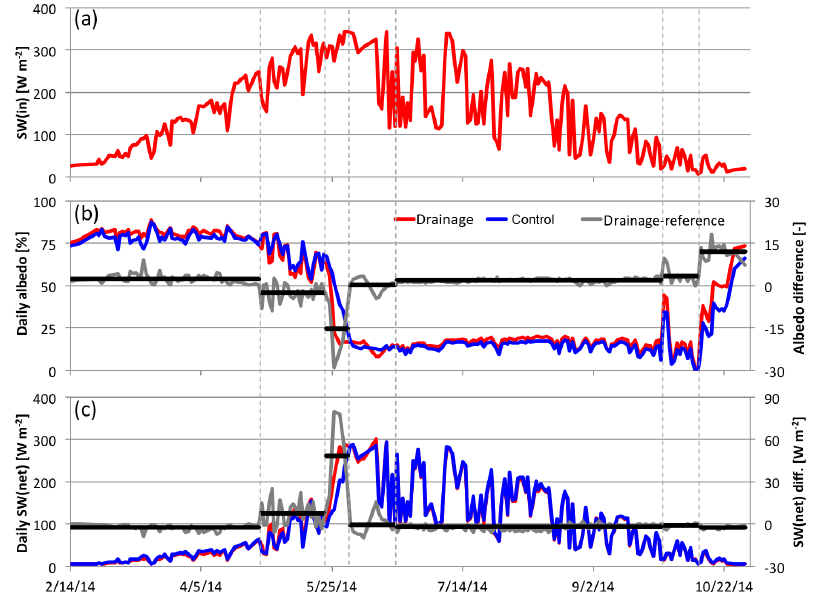
Figure 6. (a) 2014 annual course of the daily mean incoming shortwave radiation; (b) daily mean albedo derived from the ratio of downward and upward shortwave radiation. The grey line indicates the daily difference between drained and control towers (scales on the right), with the black horizontal bars giving the mean values for seven sub-seasons (separated by vertical dashed lines; see Table 2 for definitions); (c) same structure as used in the center panel, here to show the net shortwave radiation budget from both towers and their seasonal differences. All plots have been restricted to the period where SW(in) > 5Wm − 2 . Table 2. Definition of sub-seasons that reflect the pattern in albedo differences between drainage and control areas. Differences for albedo and net shortwave radiation budget SW(net) were calculated as seasonal means of daily values, drainage minus control. Dates reflect the conditions in data year 2014, and may change between